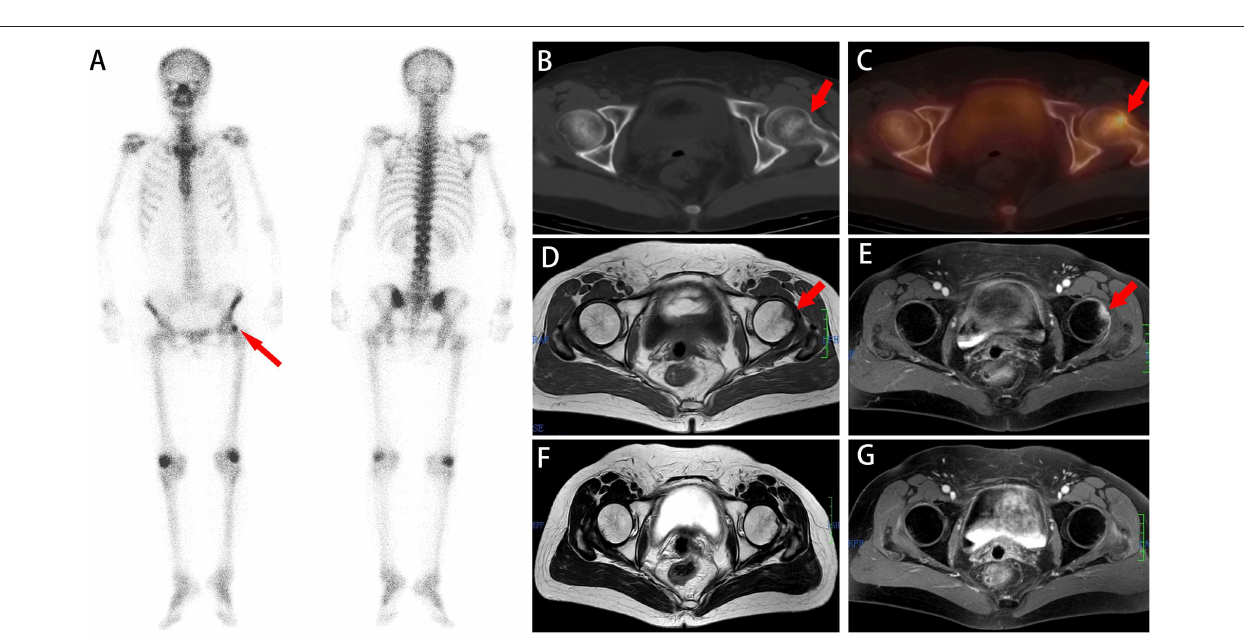
mostly in the metaphysis (16). The findings of Rikard W. also the most common, followed by proximal and distal lesions